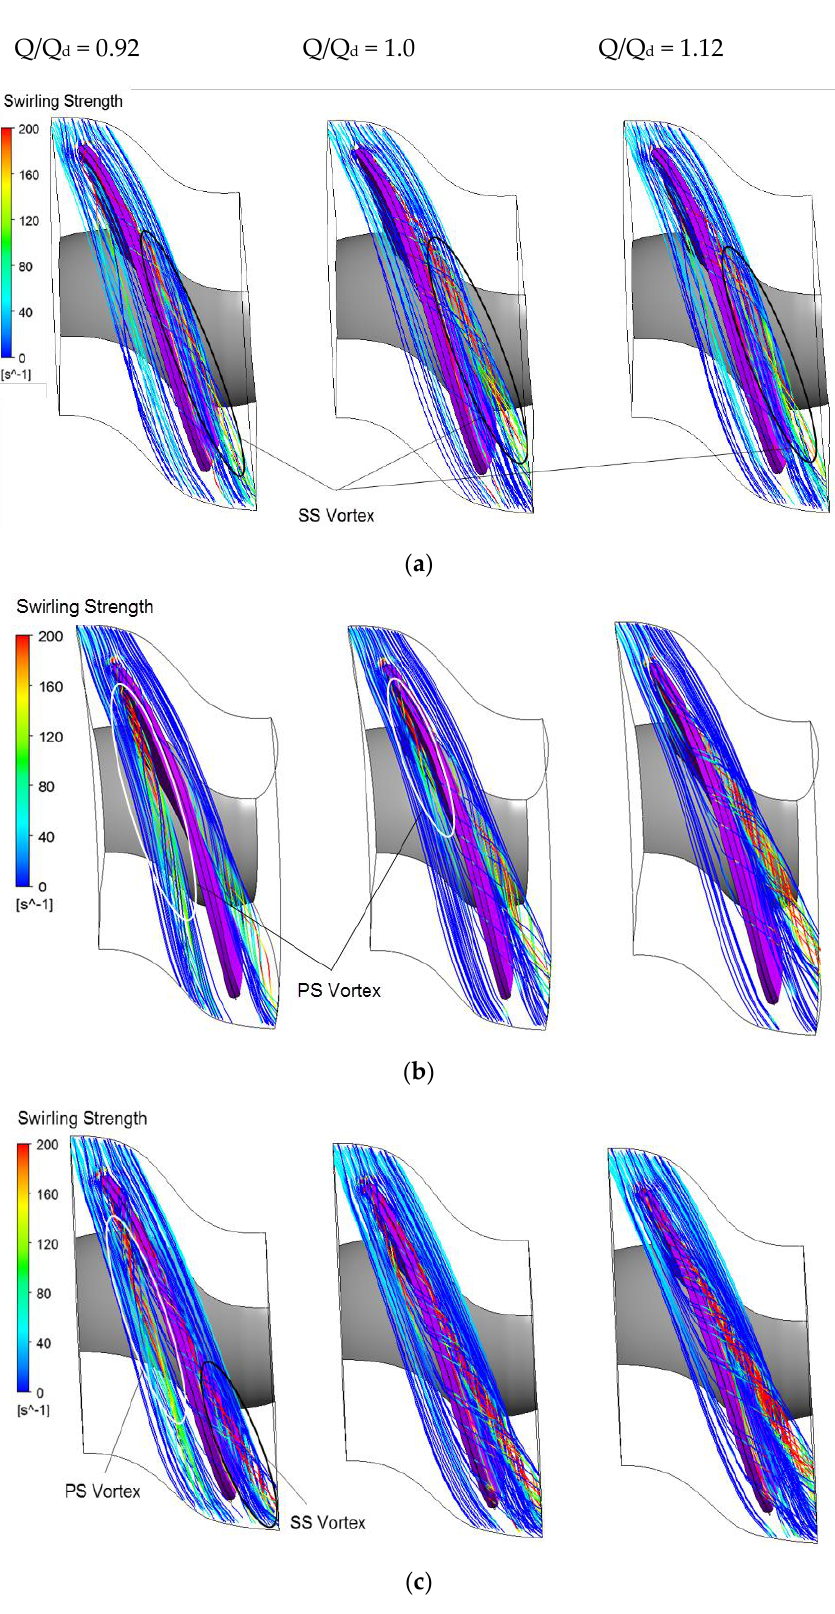
Figure 7. Tip-leakage vortex trajectory at different tip-clearance sizes and flow rates. ( a ) δ = 0.25%; ( b ) δ = 0.5%; ( c ) δ = 0.75%; (left) 0.92 Q d ; (center) 1.0 Q d ; (right) 1.12 Q d .